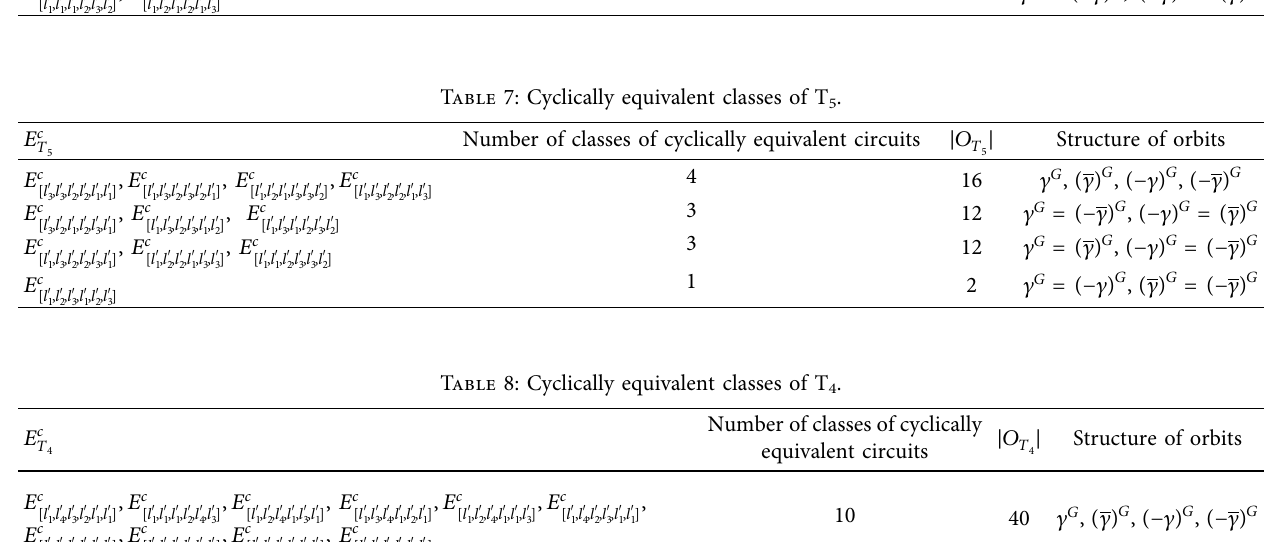
Table 9: Cyclically equivalent classes of T